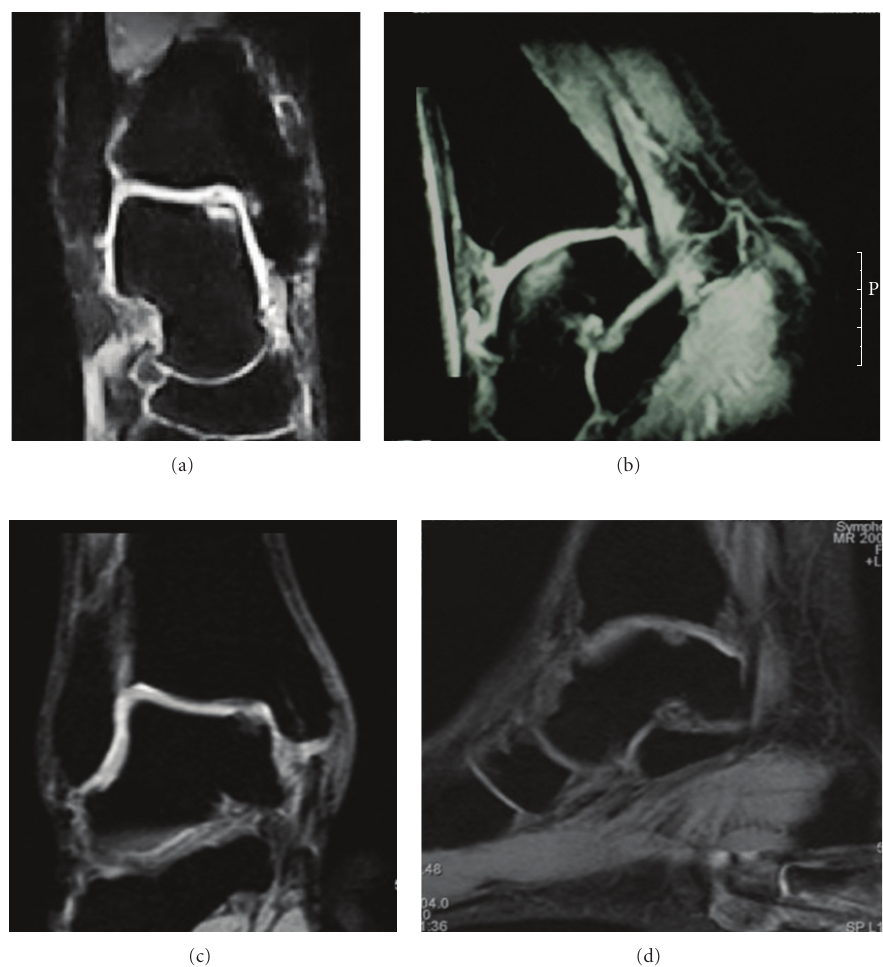
Figure 9: (a, b, c, d) Clinical case: 38-years-old man with anteromedial osteochondral lesion of the talus. Preoperative MRI images (a, b). AOFAS score was 30 points. (c, d) MRI images at follow-up (36 months). AOFAS score was 90 points.